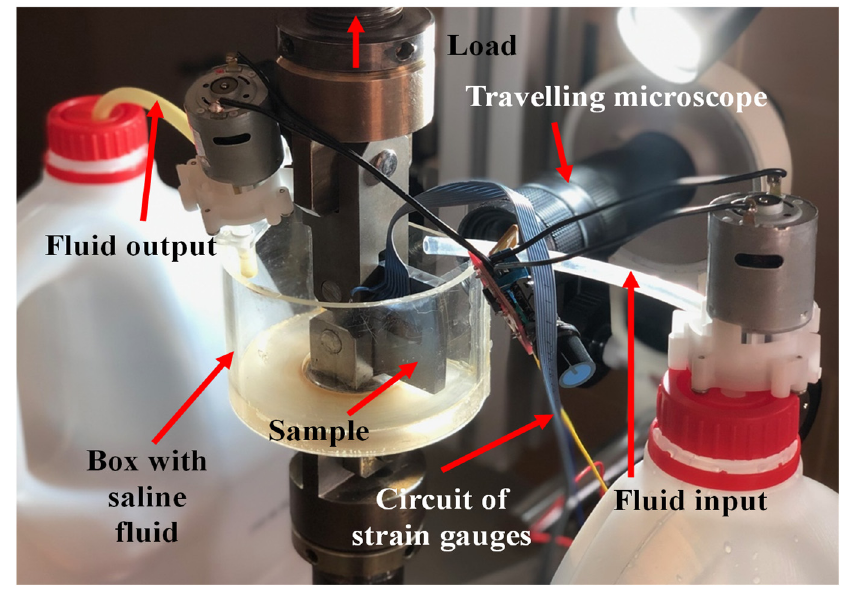
Figure 4. Testing apparatus for FCGR tests under saline corrosion.